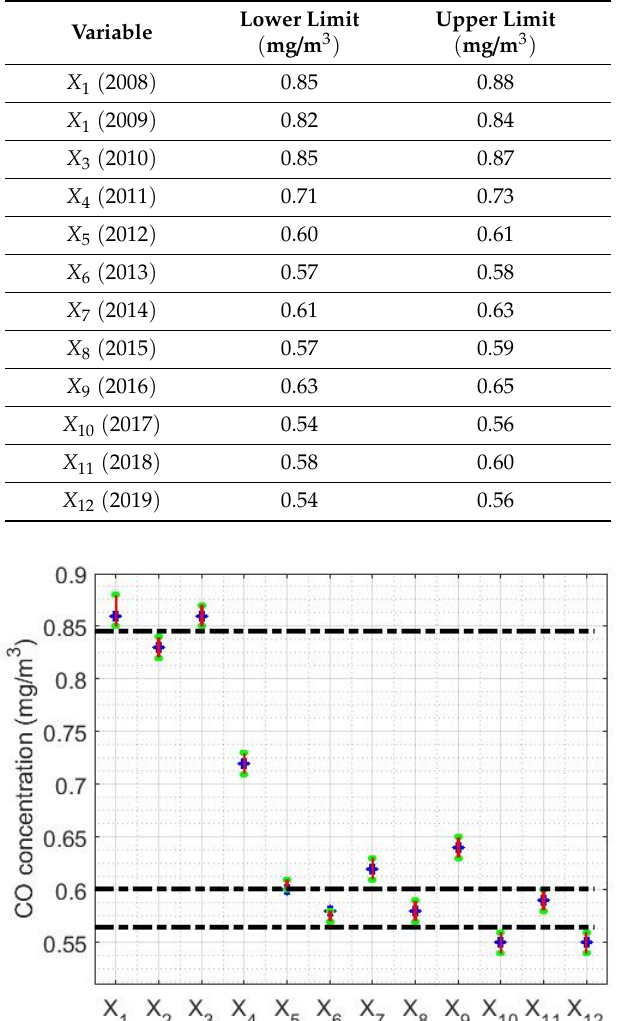
Table 2. Confidence interval limits for the median of each variable α = 0.05.